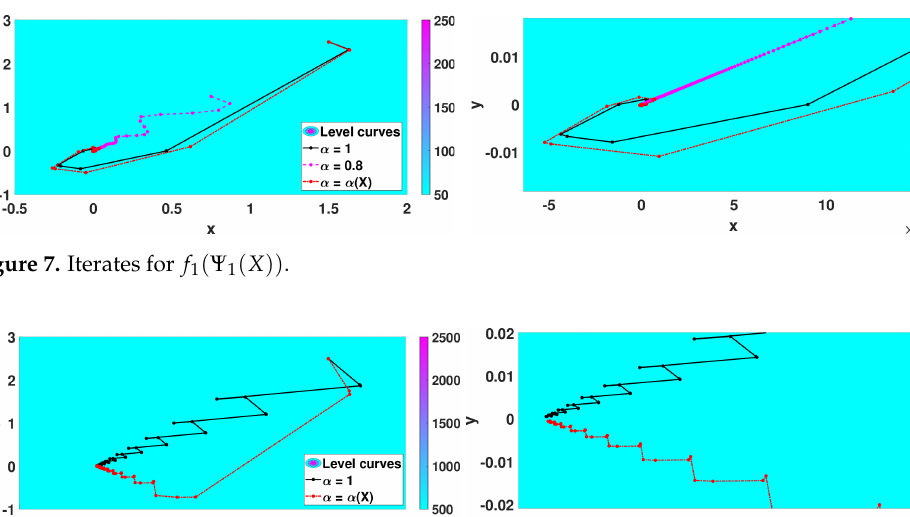
Figure 6. Graphical representations of f 1 ( Ψ 1 ( X )) and f 1 ( Ψ 2 ( X )) .